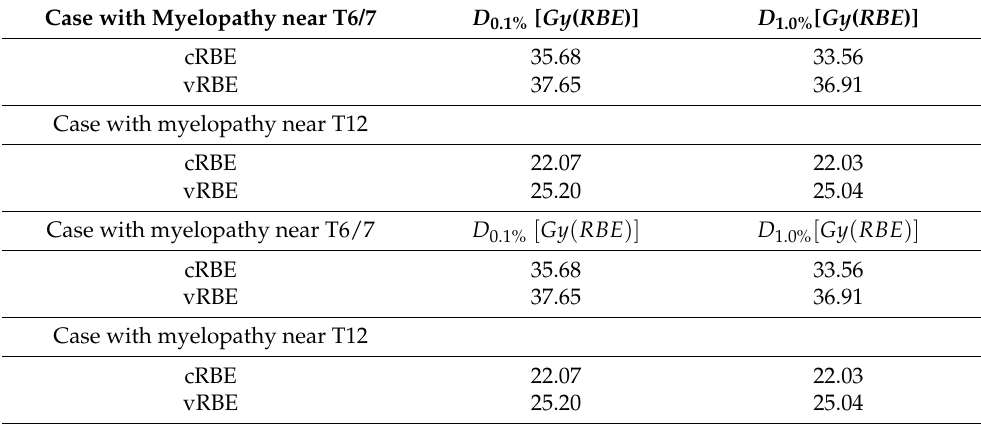
Table 4. Overview of the biological myelon dose for both 0.1 % and 1.0 % of the myelon volume considering the variable and the constant RBE in both cases with postradiotherapeutic myelopathy. Case with Myelopathy near